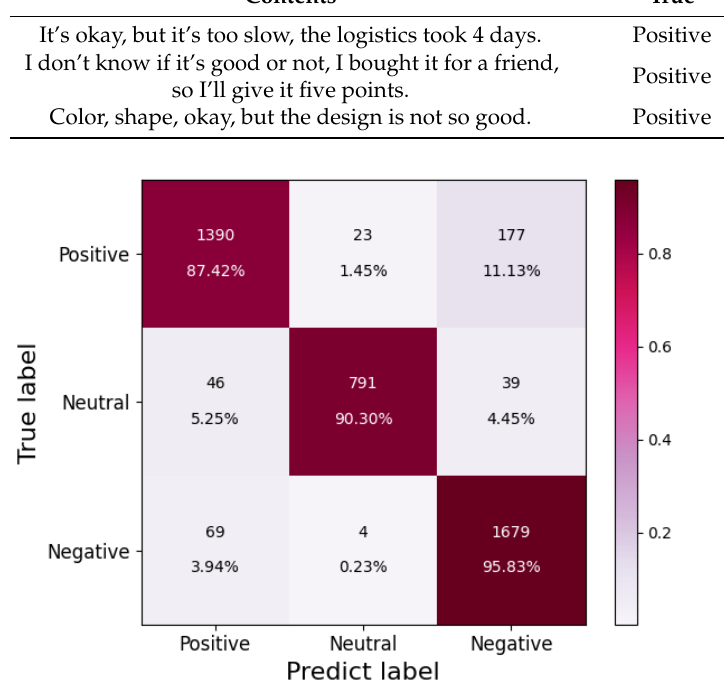
Figure 11. Test set confusion matrix.